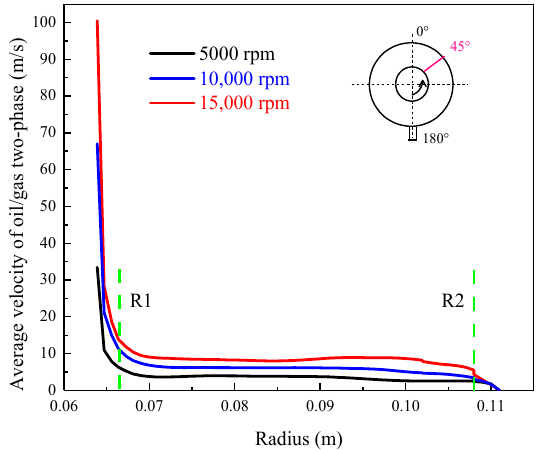
Figure 13. Radial velocity of oil/gas at different rotor speeds with the aspect ratio.